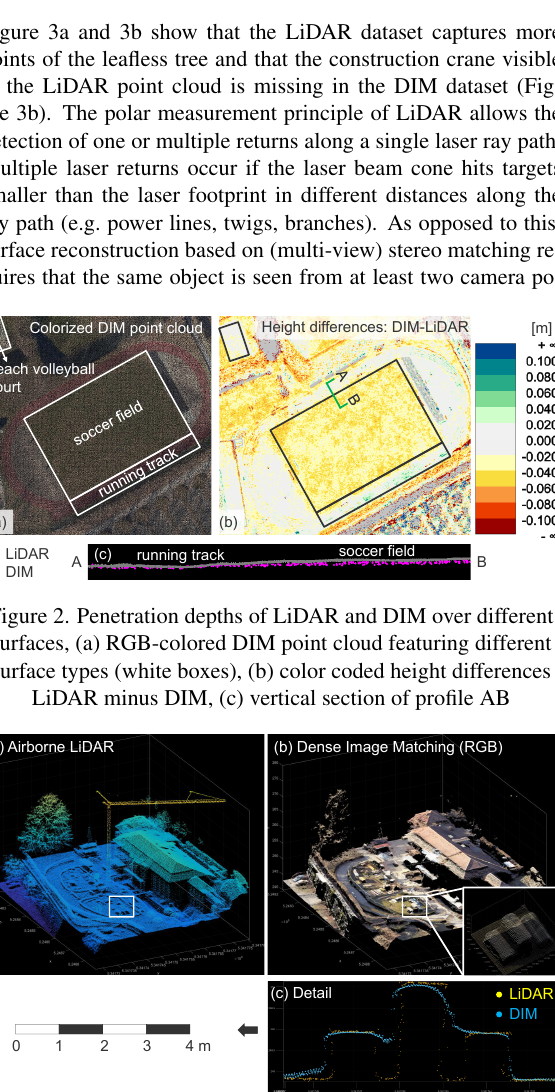
Figure 3. Comparison of 3D point clouds from LiDAR and DIM, (a) LiDAR, (b) DIM (RGB), (c) vertical section of detail (white rectangle) showing a pile of construction